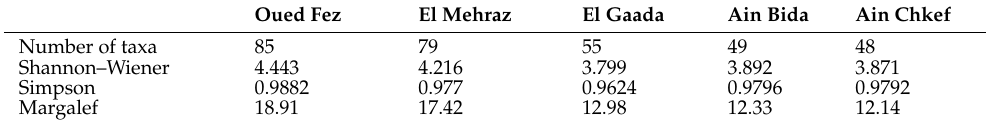
Table 2. Avian diversity among studied habitats in Fez peri-urban area between 2018 and 2019.